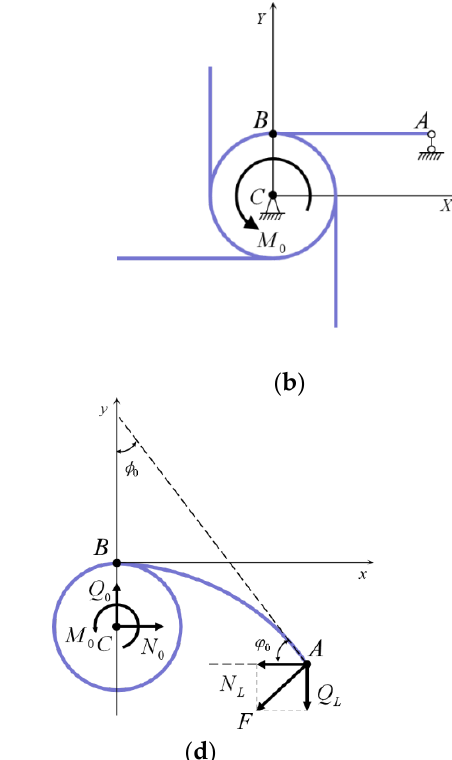
Figure 1. A schematic diagram of the deformation of ligament beams in chiral metamaterials (Point ‘ A ’ is the midpoint of the ligament beam connecting the twin cells, point ‘ B ’ is the connection point between the ligament beam and the annular node, and point ‘ C ’ is the center of the annular node.). ( a ) A schematic diagram which shows the double cells subjected to axial force and bending movement; ( b ) A schematic diagram which shows the structure of the left half before deformation; ( c ) A schematic diagram which shows the mechanical model of ligament beam deformation after rotation of the annular node by ω ; ( d ) A schematic diagram which shows the deformation of ligament beam without considering the rotations of annular nodes.